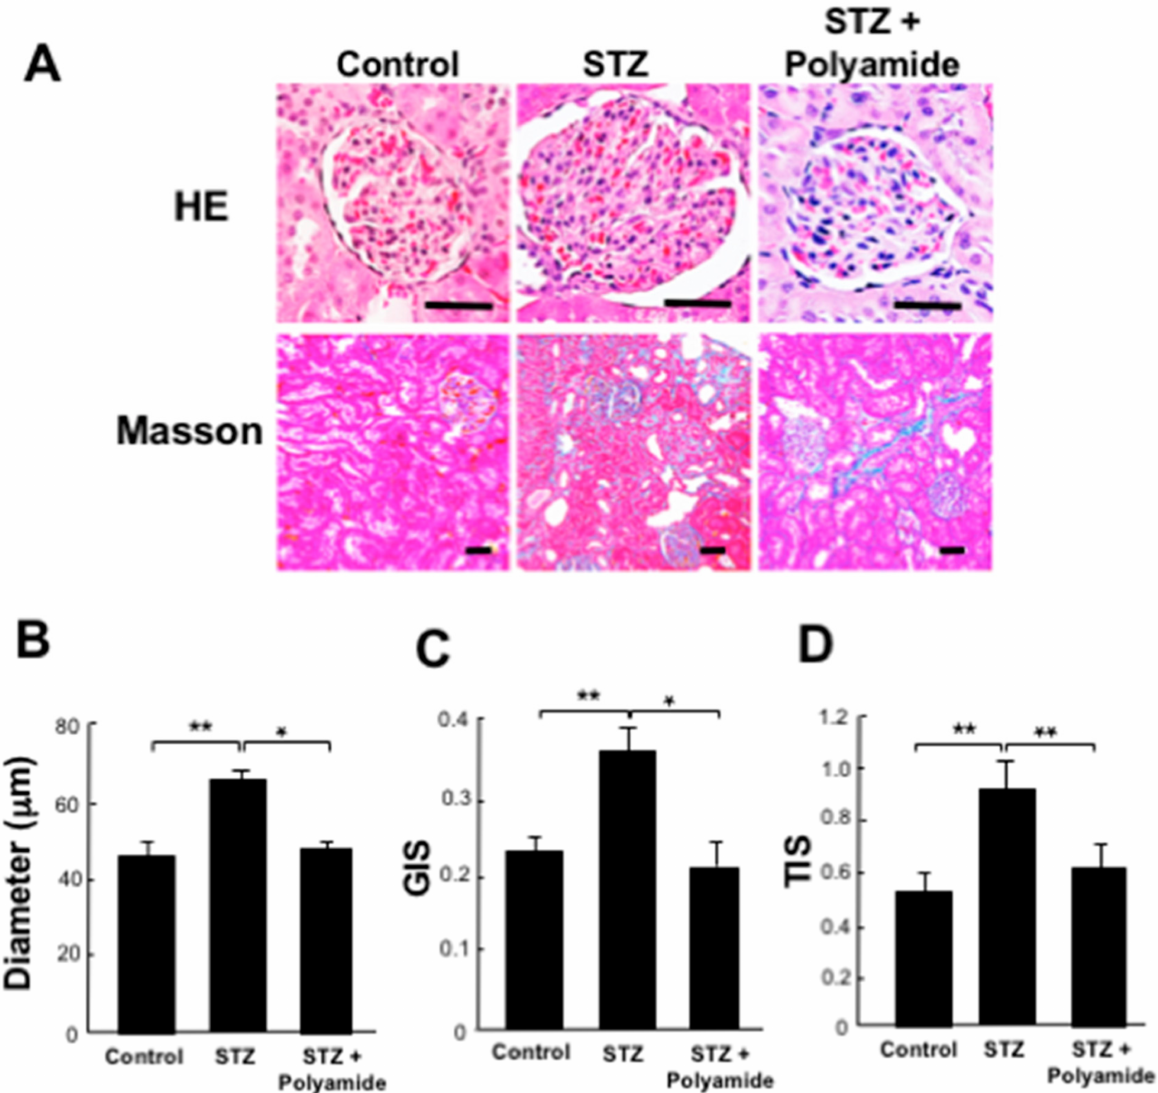
Figure 8. Effects of upstream stimulatory factor 1 (USF1) pyrrole-imidazole (PI) polyamide on kidney degeneration in diabetic rats. Diabetes mellitus was induced in rats by single intraperitoneal injection of streptozotocin (STZ). STZ-induced diabetic rats were intraperitoneally injected with 1 mL of 0.1% acetic acid as control rats. Then, 1 mg/kg body weight of USF1 PI polyamide dissolved in 1 mL of 0.1% acetic acid was intraperitonially injected twice a week for 4 months. ( A ) Three-millimeter-thick paraffin sections were stained with hematoxylin-eosin (HE) and Masson’s trichrome. Under high magnification ( × 400), ( B ) the diameter of the glomerulus in the renal cortex was measured. ( C ) Glomerular injury score (GIS) and ( D ) tubulointerstitial injury score (TIS) were evaluated. Data are the mean ± SEM ( n = 8). * p < 0.05, ** p < 0.01 between indicated columns. The scale bar indicates 25 µ